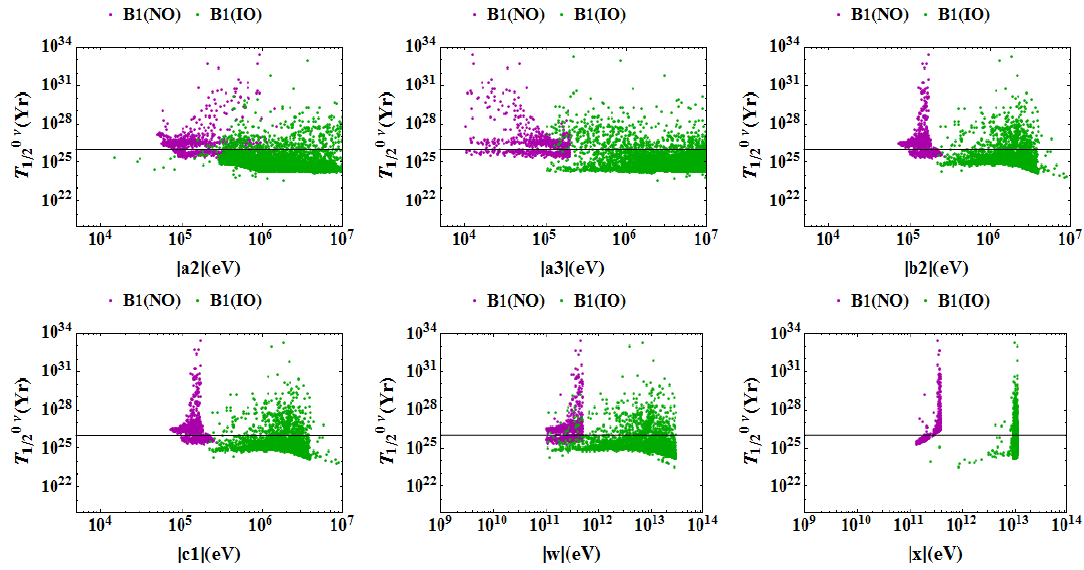
for the class B1. The horizontal line represents the KamLAND-Zen lower limit.